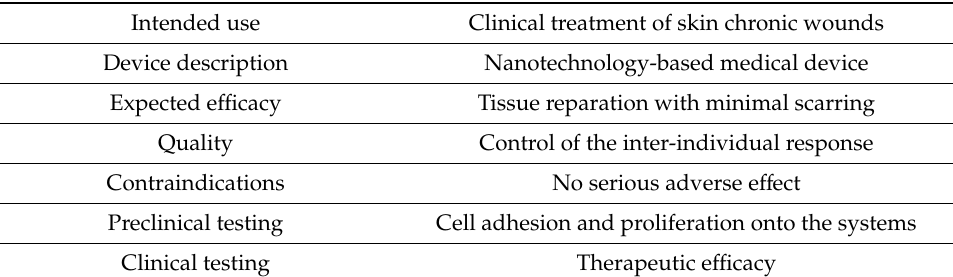
Table 2. Quality target product profile.